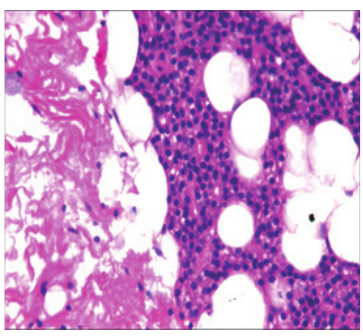
Figure 3 Histological examination showed in fibrous cystic wall of parathyroid cysts, some of the inner wall of the capsule were covered with a single layer of flat epithelium, some were not covered with cells, and a small cluster of parathyroid tissue were extruded and deformed in the wall of the capsule. (HE, original